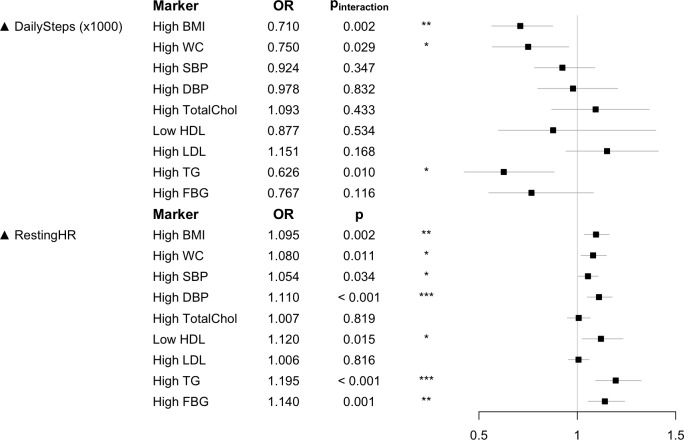
Associations between wearable data (DailySteps and RestingHR) and CVMD risk markers.The forest plot shows the effect and significance of wearable metrics as predictors for clinical risk markers. For steps, the OR is for each additional 1,000 steps. For RestingHR, the OR is for each additional bpm. Details of models used in the logistic regressions and the thresholds used to define the clinical features are provided in the Materials and methods section. p-Values and ORs for DailySteps are for interactions between gender and steps, with the female gender being the reference level. The code to generate this figure can be found in S2 Data. bpm, beats per minute; BMI, body mass index; CVMD, cardiovascular and metabolic disorder; DailySteps, average daily steps; DBP, diastolic blood pressure; FBG, fasting blood glucose; HDL, high-density lipoprotein; LDL, low-density lipoprotein; OR, odds ratio; RestingHR, wearable-derived RHR; RHR, resting heart rate; SBP, systolic blood pressure; TG, triglyceride; TotalChol, total cholesterol; WC, waist circumference.